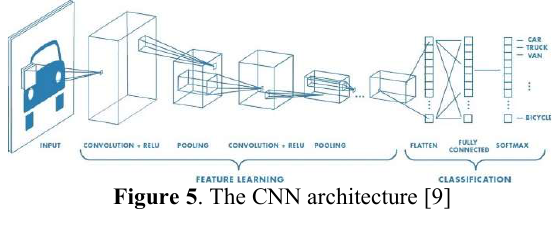
Figure 5 . The CNN architecture [9]